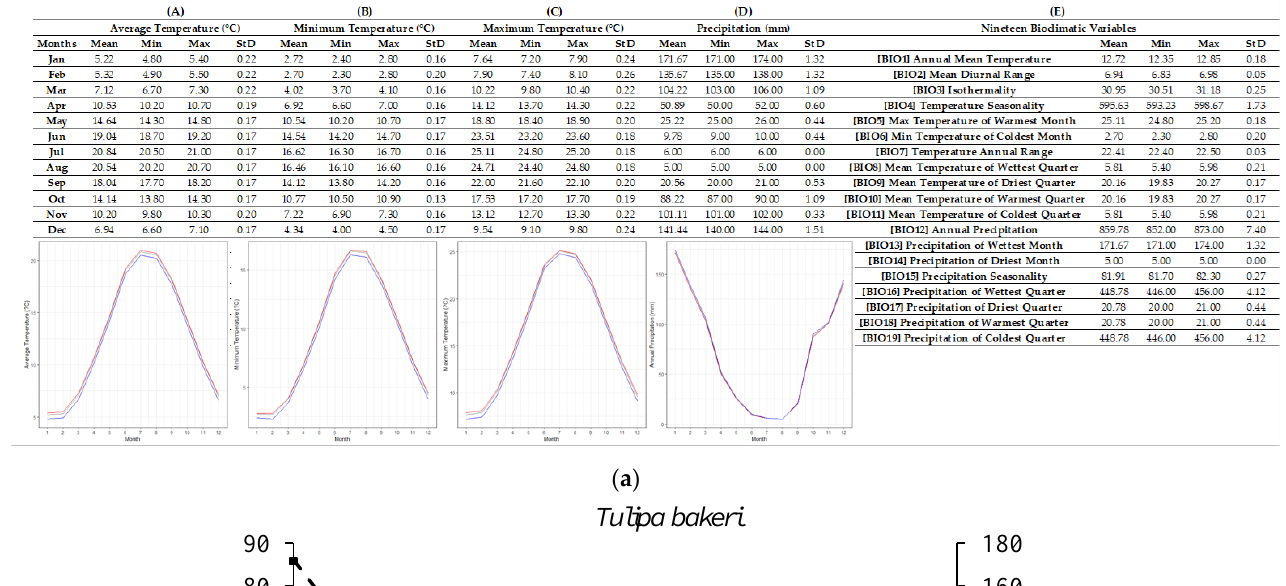
values and standard deviations are represented in different columns. Line graphs ( A – C ) illustrate